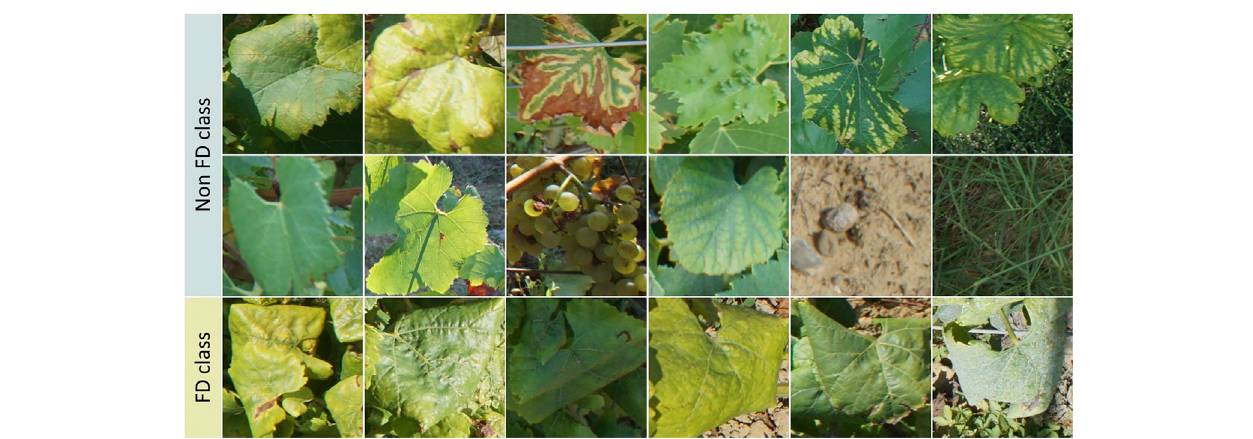
Table 1 summarises the information about the datasets used to train the CNN classi fi er and to evaluate the FCN model.